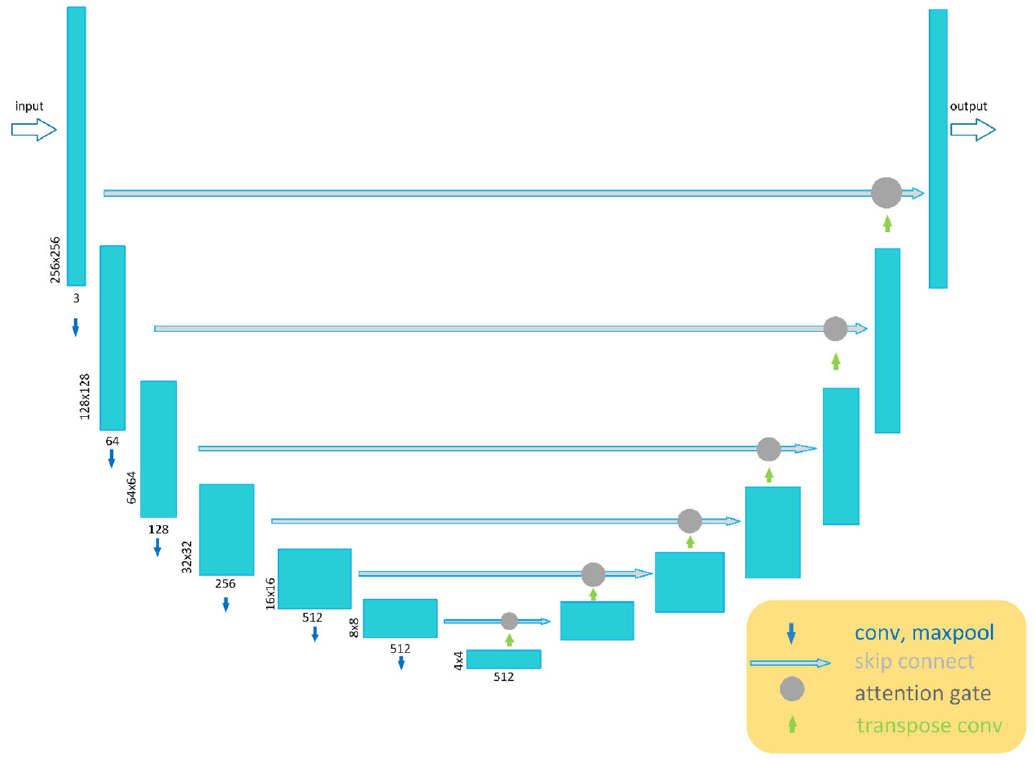
Figure 2. The generator architecture of our model is illustrated as follows. Each blue box represents a multi-channel feature map, and the number of channels is denoted at the bottom of the box. The xy size is provided at the lower left edge of the box.